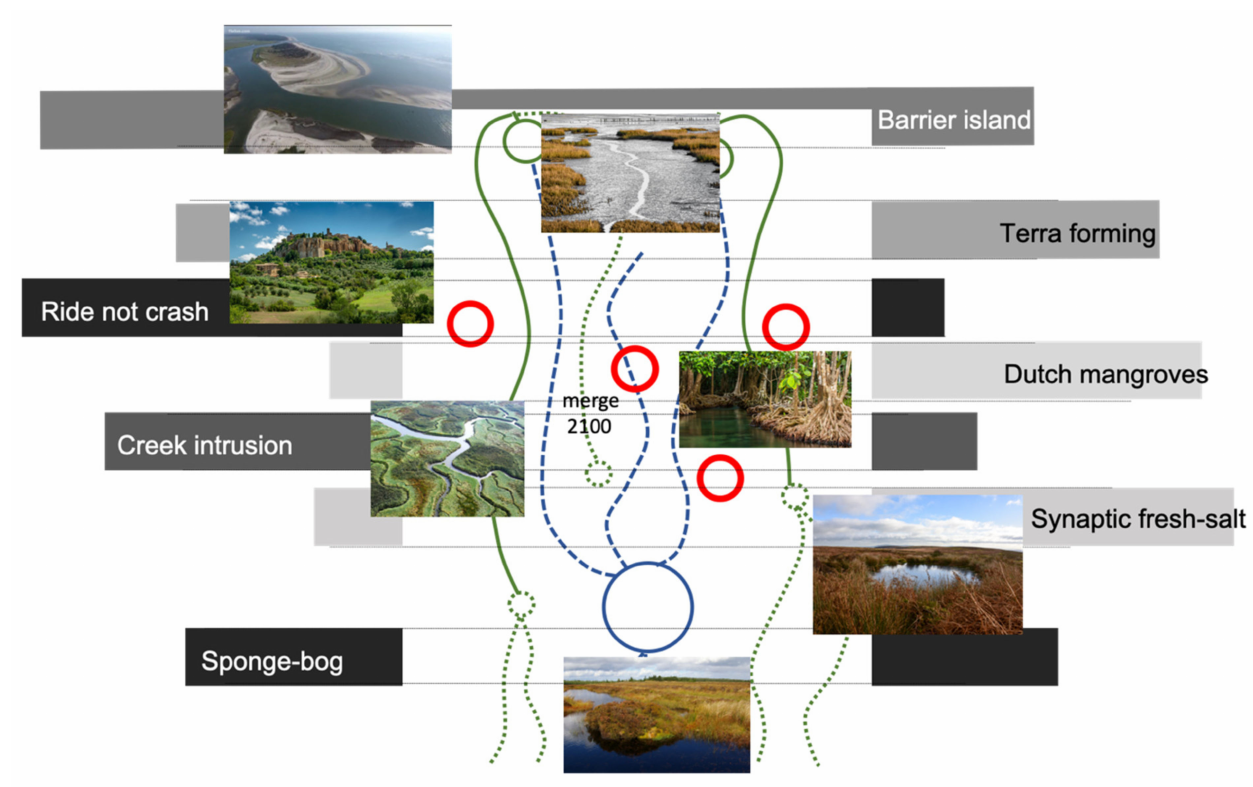
Figure 10. Subsequent lines of protection projected in the northern